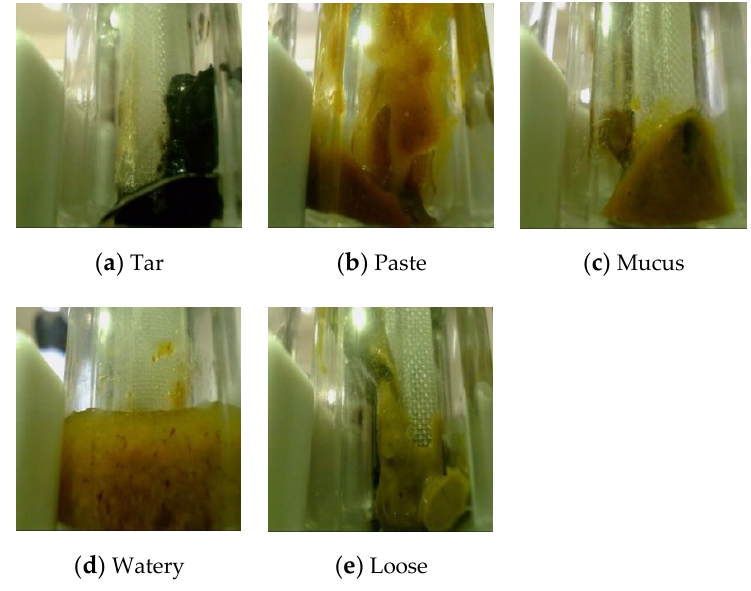
Figure 1. Feces trait classes.